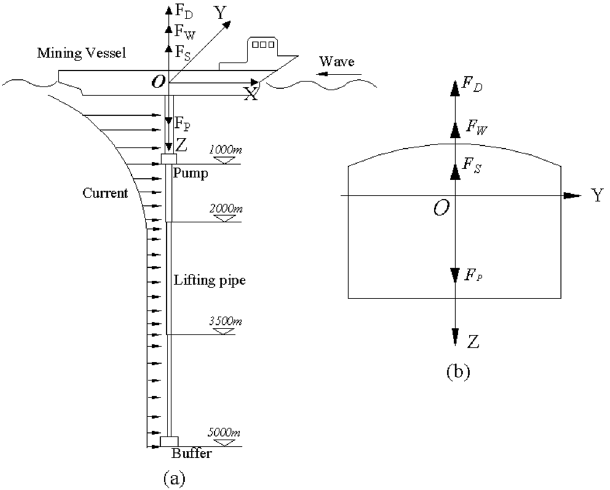
Figure 3. Mechanical model of vessel-pipe coupling system: ( a ) Model of mining system, ( b ) Section diagram of mining vessel (created by AutoCAD 2020 software,URL: https:// www. autod esk. com.